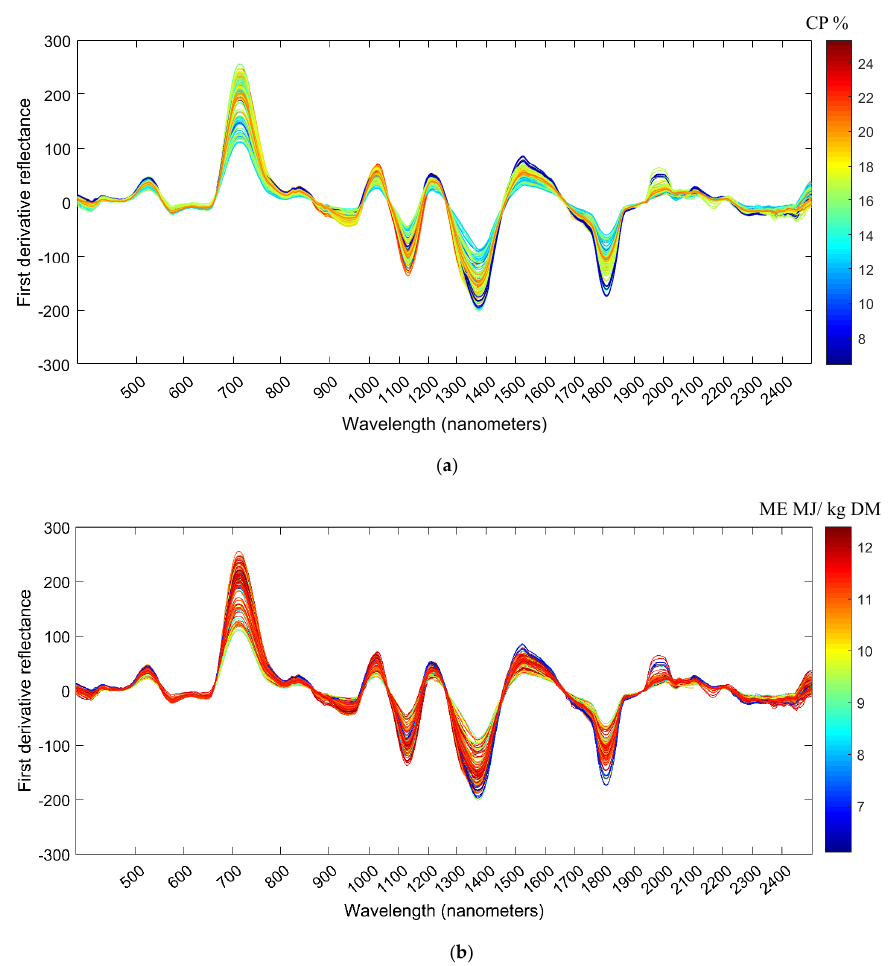
Figure 4. First derivative reflectance of pasture as a function of spectral wavelength. The color of the spectra indicates the content of CP ( a ) and ME ( b ).